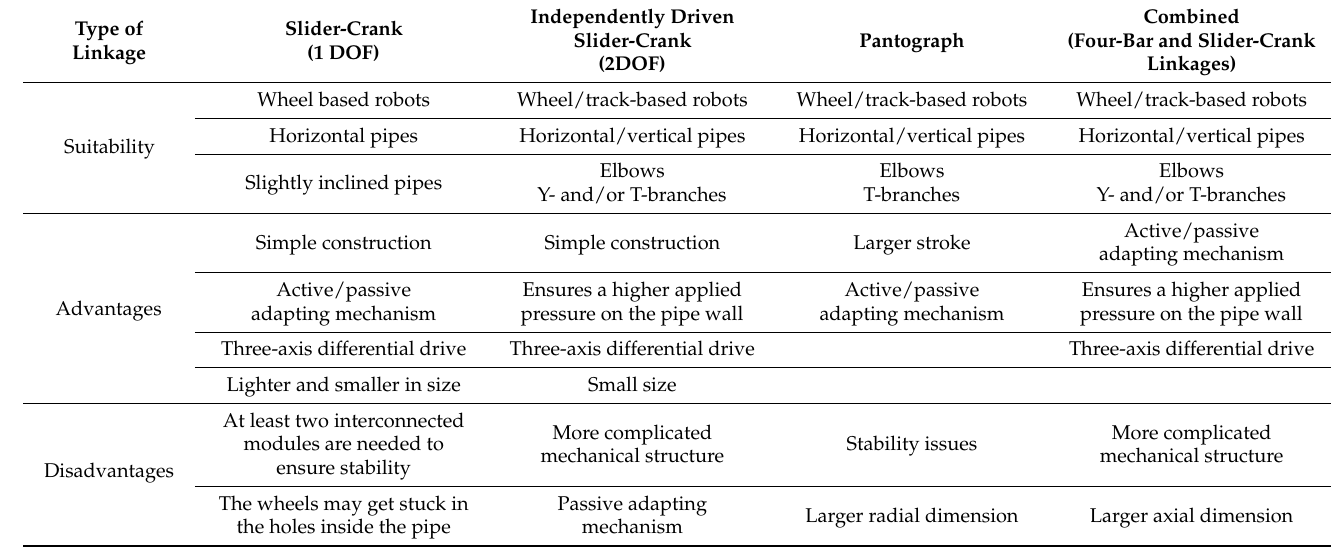
Table 2. Comparison between the linkages used in the adapting